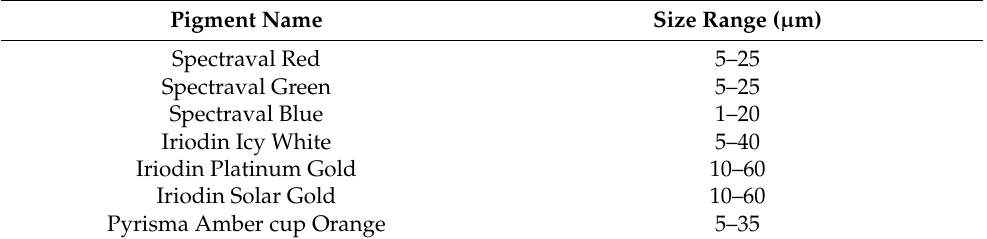
Table 1. Size range of Merck specialty pigments used in the amber project. The size range was provided by